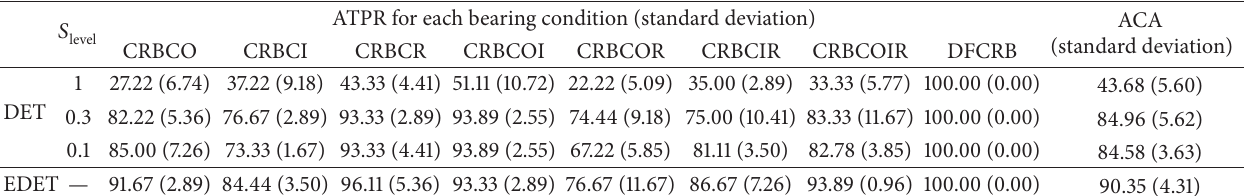
Table 4: Performance comparison between the conventional DET and the proposed EDET in terms of average classification accuracy and true positive rate via k -fold cross validation (Unit: %).